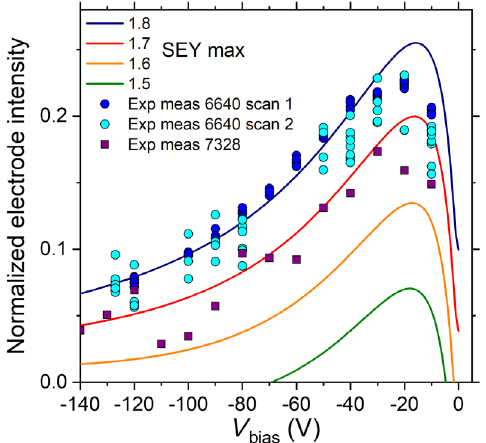
FIG. 14. Comparison between calculated intensities from different energy spectra and a maximum SEY of 1.7 (lines), and experimental data (purple squares) recorded on the electrode K6517A for a negative bias scanning performed during fill 7328.